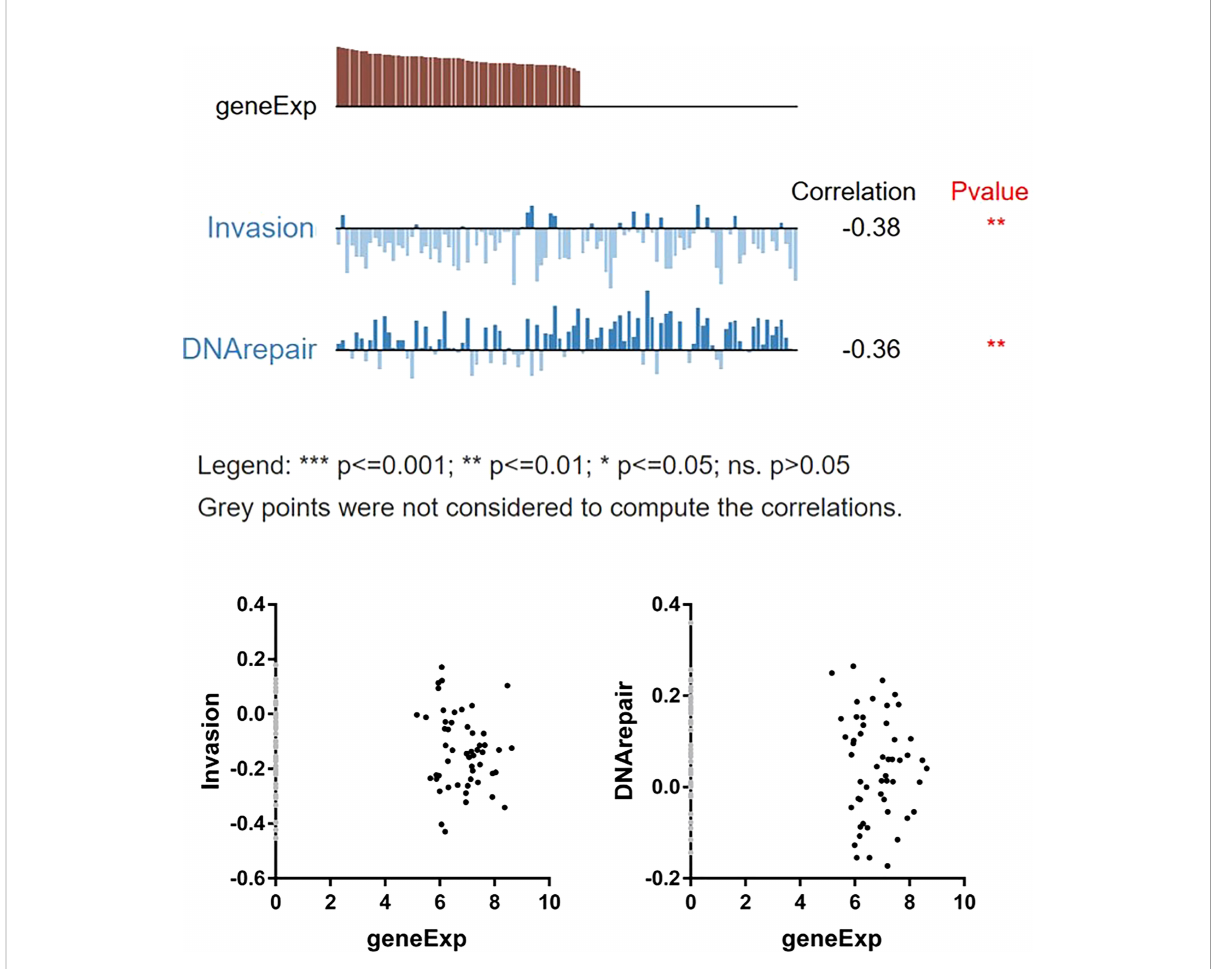
FIGURE 8 Correlation between STAT5A and functional states of OV